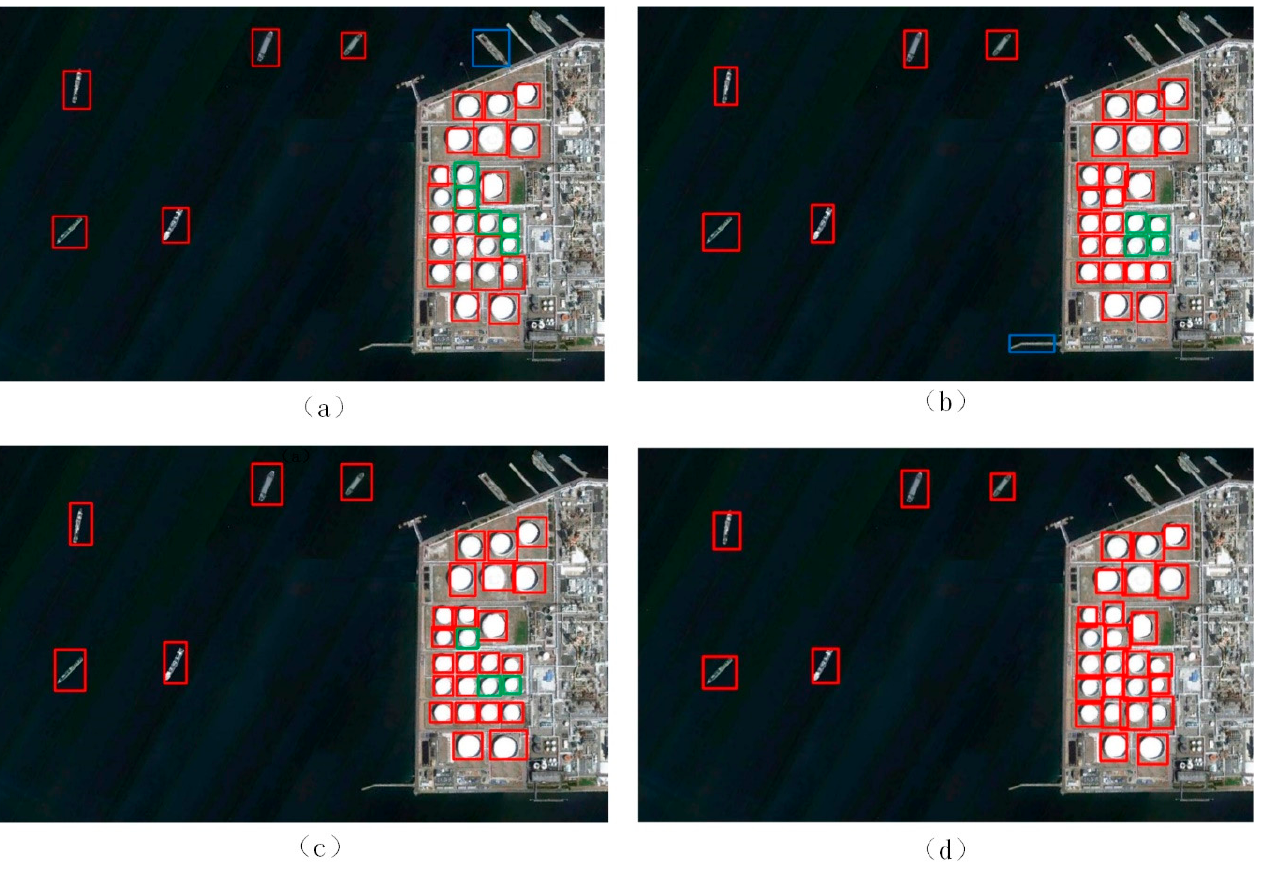
Figure 10. Some target detection results of some different methods. ( a ) FRCNN-VGG; ( b ) YOLO3; ( c ) SSD; ( d ) DCIFF-CNN.